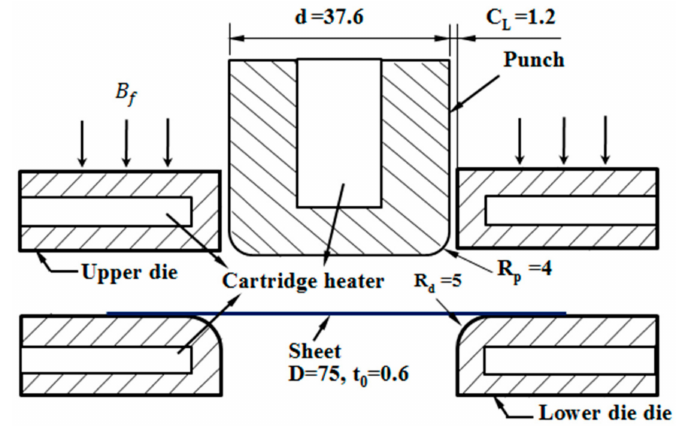
Figure 2. Die construction and dimension for deep drawing (unit: mm, B f : Blank holding force, C L : clearance between punch and